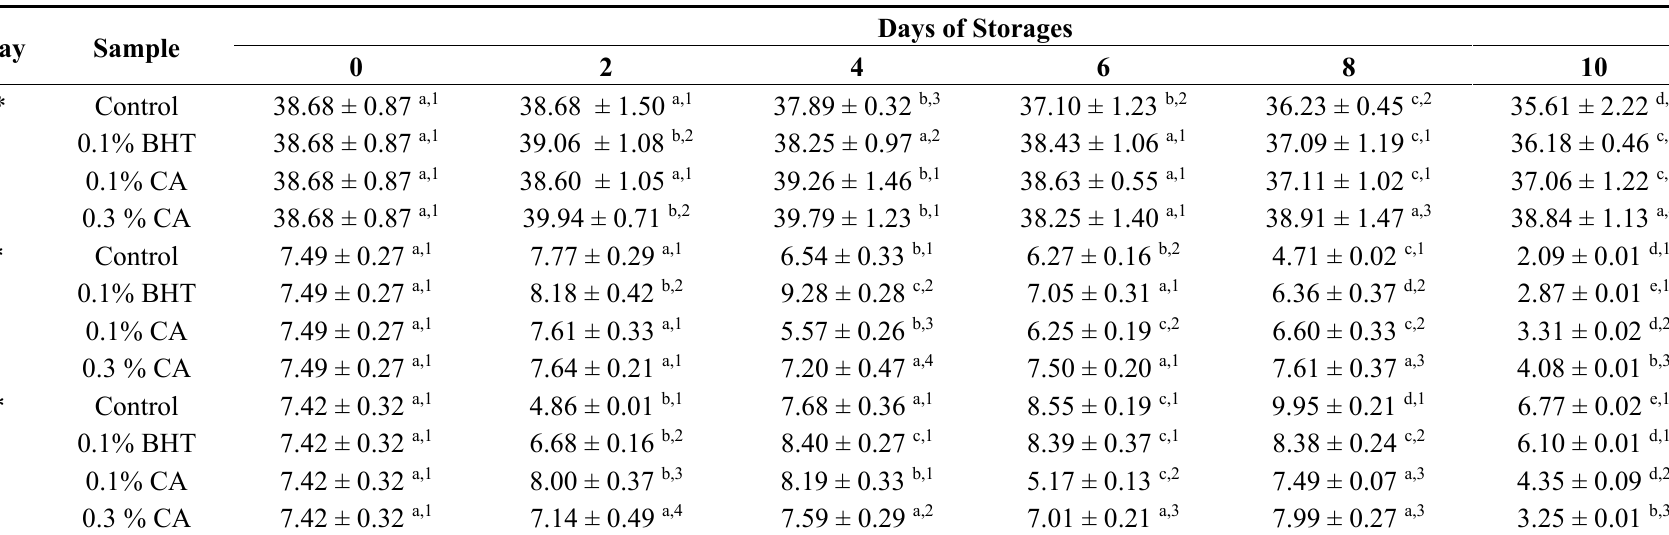
Table 2. Effect of CA extract and BHT on instrumental colour value (L*, a*, b*) of beef patties during 10 days of refrigerated storage at 4 °C. (Mean ±